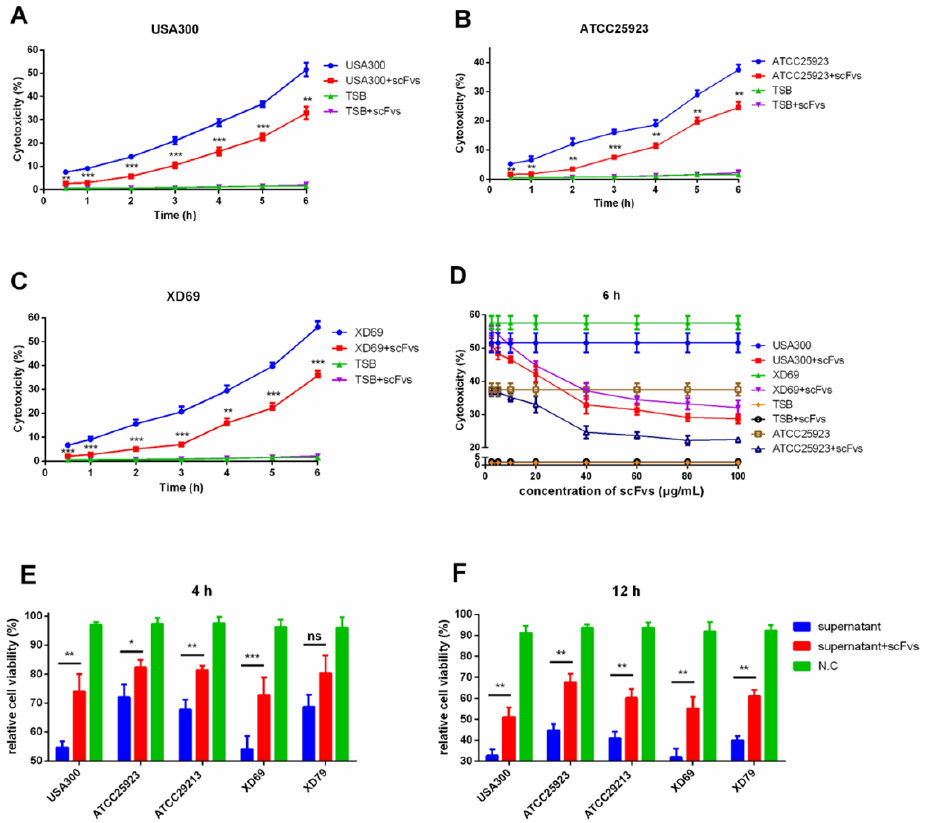
Figure 6. LDH cytotoxicity assay and relative cell viability assay. LDH release of MAC-T cells infected by strain USA300 ( A ), ATCC25923 ( B ), XD69, ( C ) over time. ( D ) LDH release of MAC-T cells after treatment with three S. aureus strains and the mixture of various concentrations of scFvs. Relative cell viability of MAC-T cells infected by five S. aureus strains in 4 h ( E ) and 12 h ( F ). Data represent mean results ± SD ( n = 3) (ns = p > 0.05, * p < 0.05, ** p < 0.01, *** p <